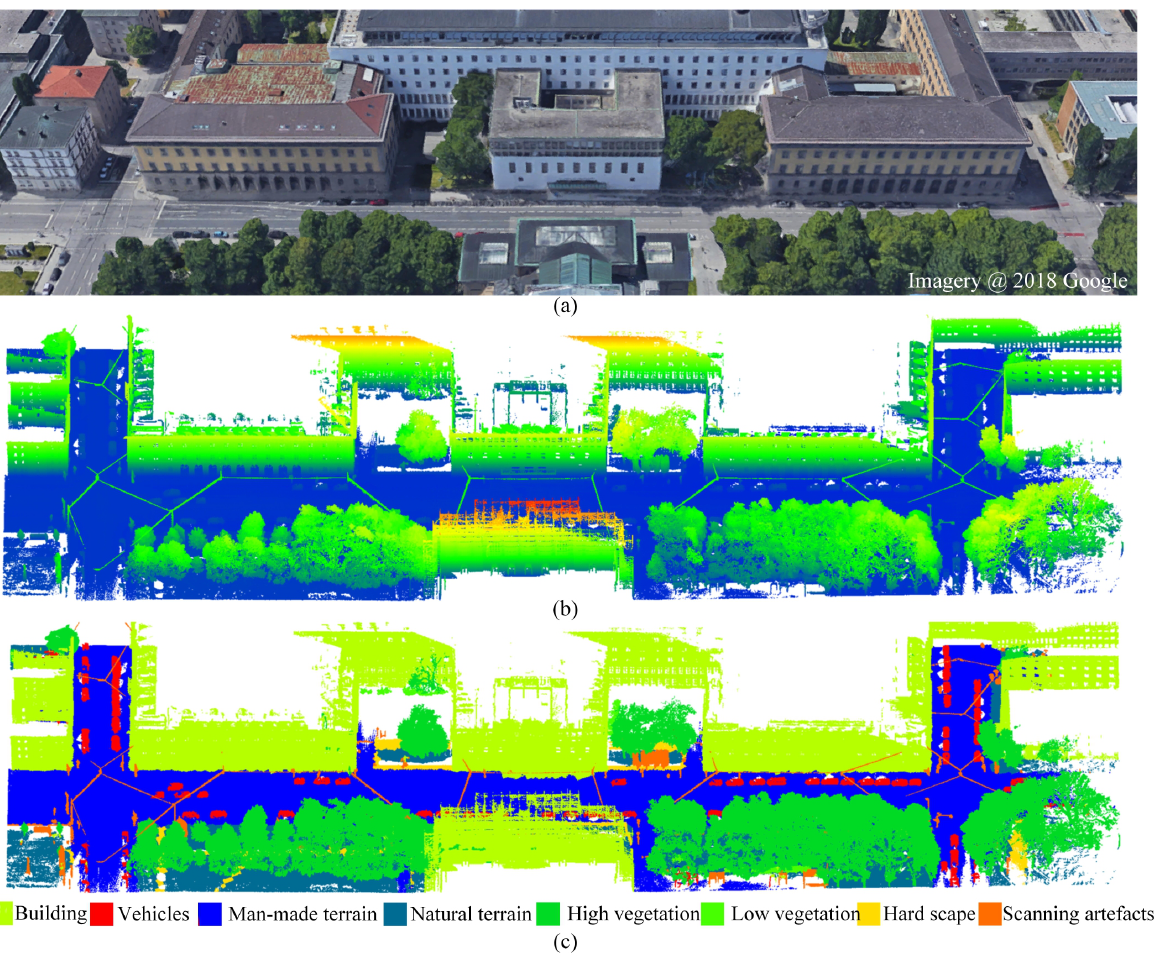
Figure 1. (a) Real scene of the TUM main entrance from Google Maps, 2018. (b) MLS point cloud colored with respect to height. (c) Classified point cloud of the test scene with eight different semantic labels